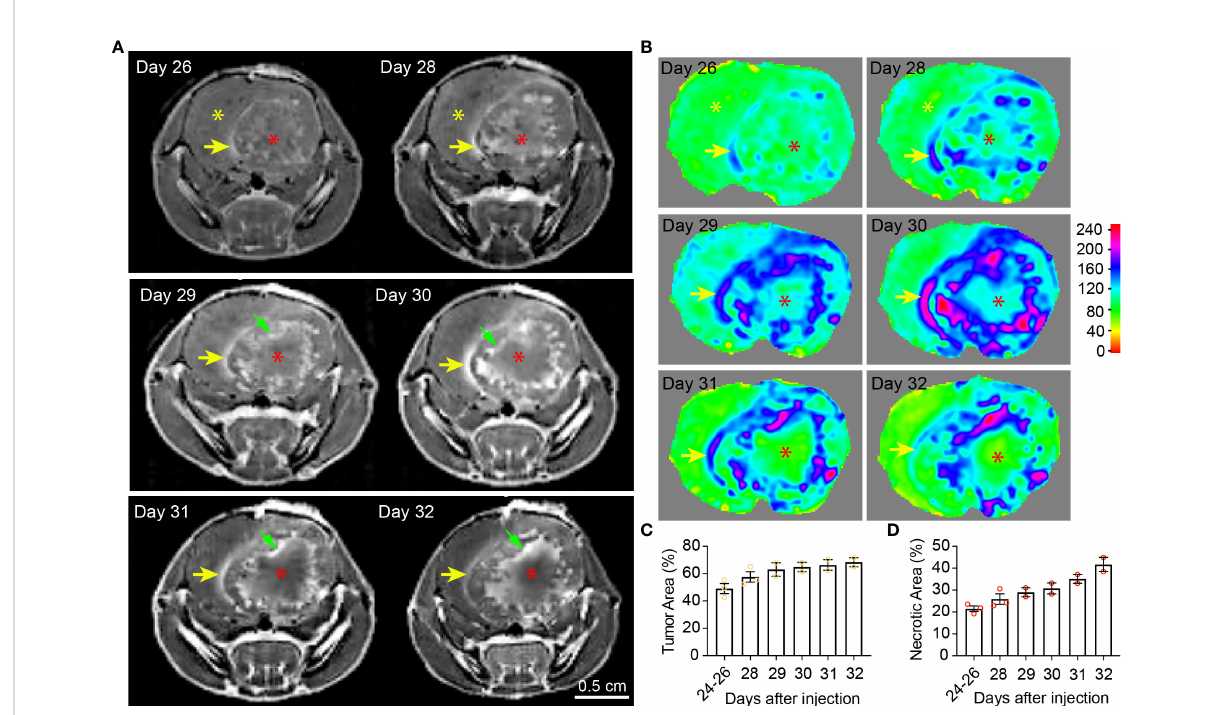
FIGURE 2 Temporal radiographic characterization of tumor necrosis development during late tumor progression via MR imaging. (A) Temporal development of GBM tumor necrosis during late tumor progression after onset of overt tumor-associated symptoms in tumor-bearing mice via representative serial T1-weighted post-gadolinium MRI scans of one LN229TAZ(4SA) tumor-bearing mouse (different from the animal used in Figure 1). Yellow asterisks: Brain parenchyma in the normal hemisphere; yellow arrows: More prominently enhancing rim at the outer edge of the tumor boundary, representing the tumor-in fi ltrating front; red asterisks: More prominently enhancing (but later unenhancing from day 29 onward) foci within the tumor stroma, representing active development of necrosis; green arrows: Prominently enhancing rim at the necrosis- cellular tumor (N-CT) interface, representing areas of active in fl ammation. (B) Heatmaps of signal intensities generated using T1 post-contrast MRI images as in panel (A) . (C) Quanti fi cation of tumor area (outlined by the peripheral enhancing interface indicated by yellow arrows) normalized to whole brain area at each timepoint indicated above. p=0.3684. (D) Quanti fi cation of necrotic areas — labeled by red asterisks as in panel (A) — normalized to corresponding tumor area at each indicated timepoint as above. p=0.1164. Three mice were imaged as replicates until reached the terminal stage (one at day 28, the other two at day 32; n=2-3); each datapoint shown in the bar graphs represents an animal. All center values shown are mean values, and all error bars represent standard errors of the means (s.e.m). Mixed-effects